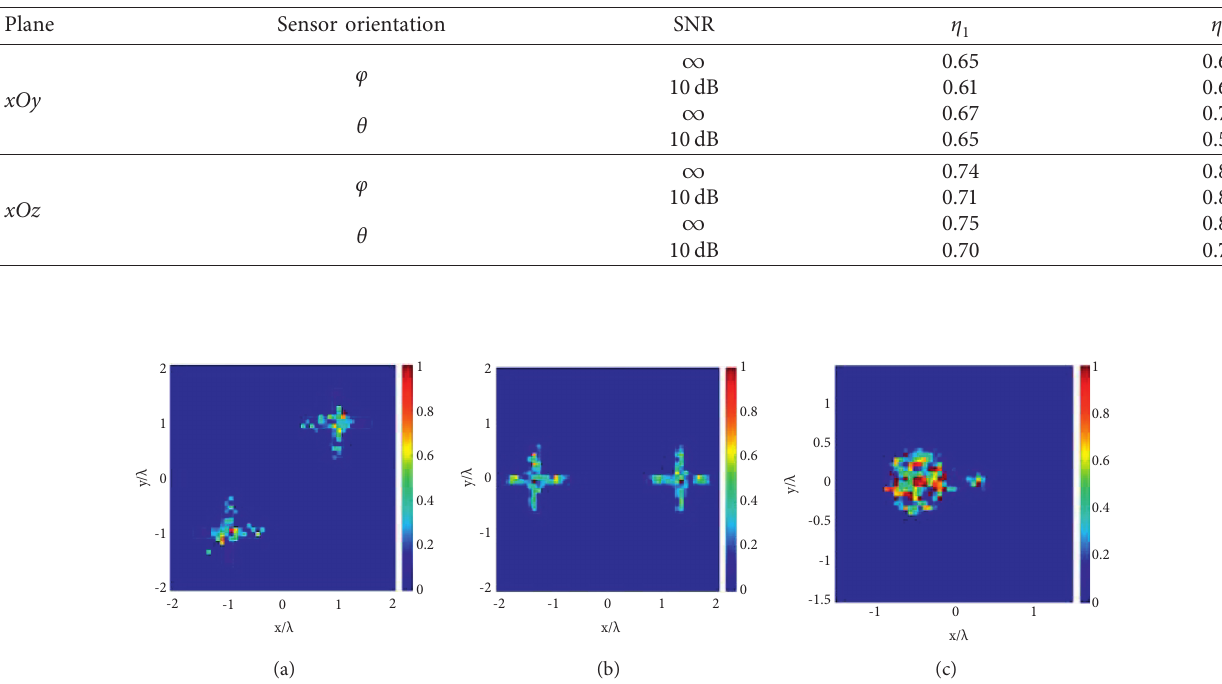
Table 3: Parameters η